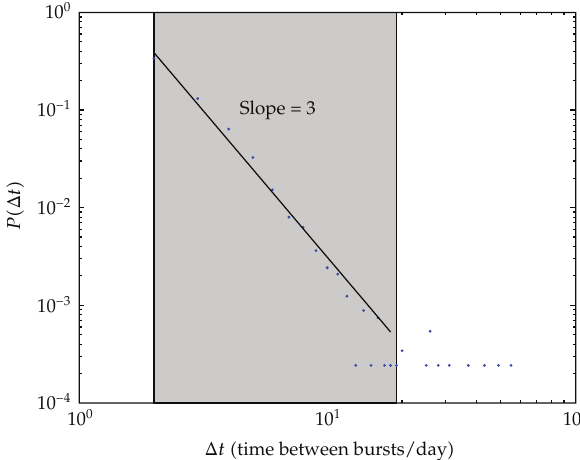
Figure 4: Distribution of popularity burst, which follows power-law with slope (cid:8) 3.0.